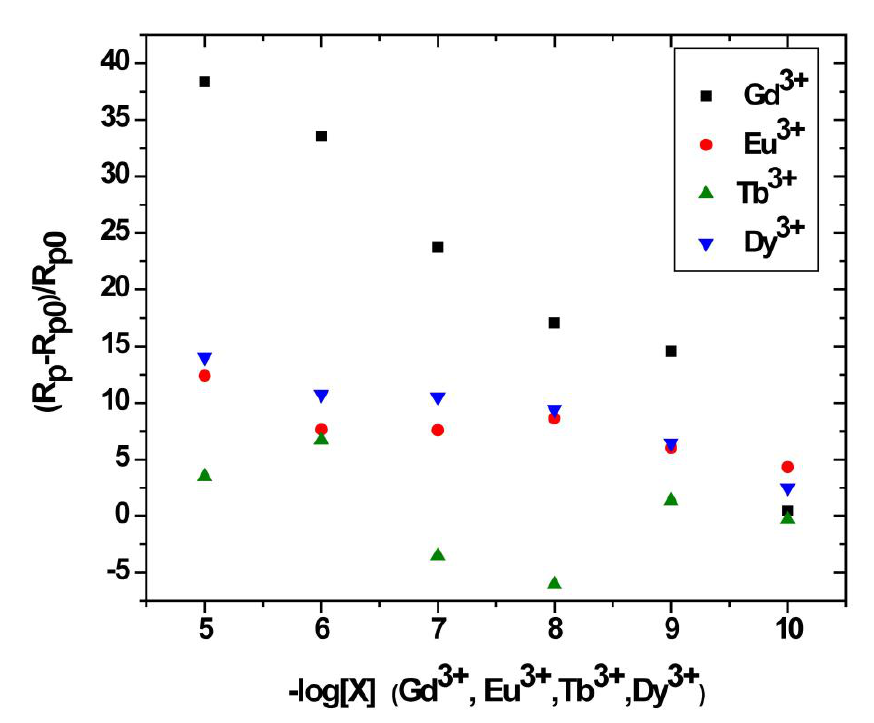
Figure 11. Relative variation of the polarization resistance of bis-N-MPyC sensor as a function of − log[X] for X = Gd 3+ , Eu 3+ , Tb 3+ and Dy 3+